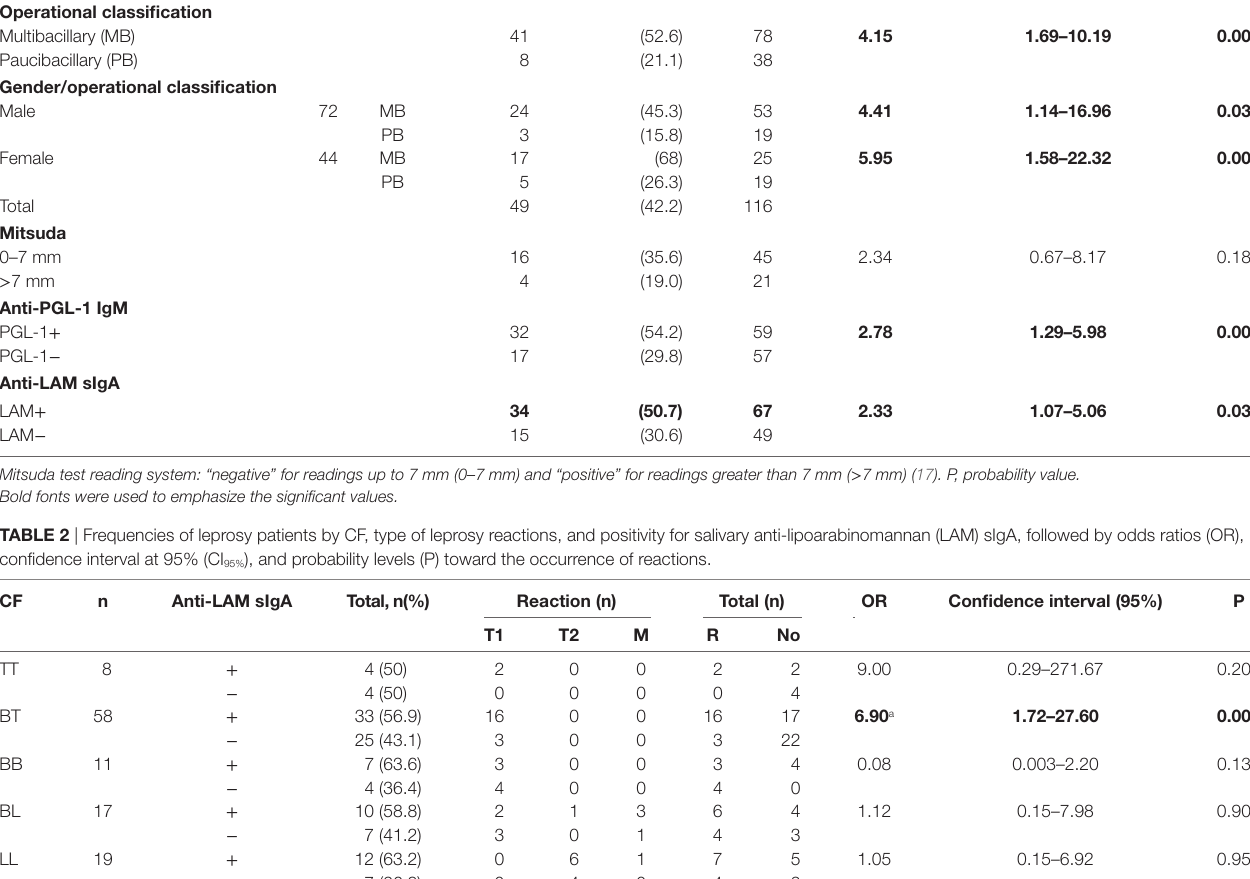
Bold fonts were used to emphasize the significant values. a Statistically significant.